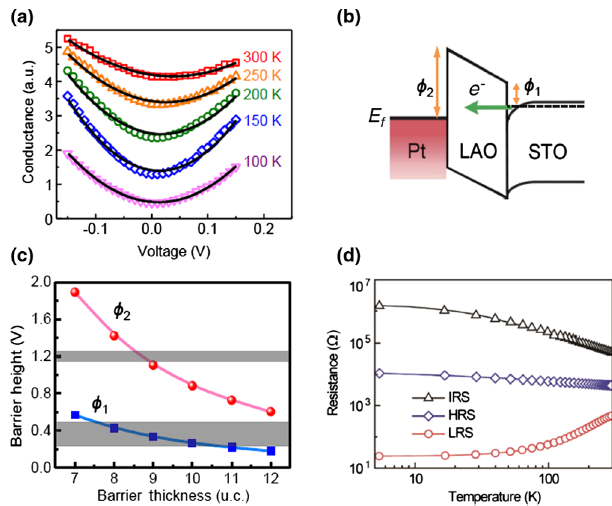
FIG. 5. (a) Junction conductance vs voltage data for the pris- tine state (IRS) measured at different temperatures. The black lines are the theoretical fitting results using the BDR model expected for direct tunneling junctions. (b) Schematic energy diagram of the Pt/LAO/STO heterojunction where the two asymmetric barriers are labeled as (cid:2) 1 and (cid:2) 2 . (c) Derived barrier heights plotted as a function of the LAO thickness. The two gray belts mark the ranges of barrier heights calculated in Ref. [56]. (d) Temperature dependence of the memristor resist- ance at different states. During the measurements, a constant voltage bias of 0.15 V is used. Overall, the forming and switch- ing processes of the memristor correspond to reversible transi- tions between tunneling and Ohmic transport characteristics of the Pt/LAO/STO